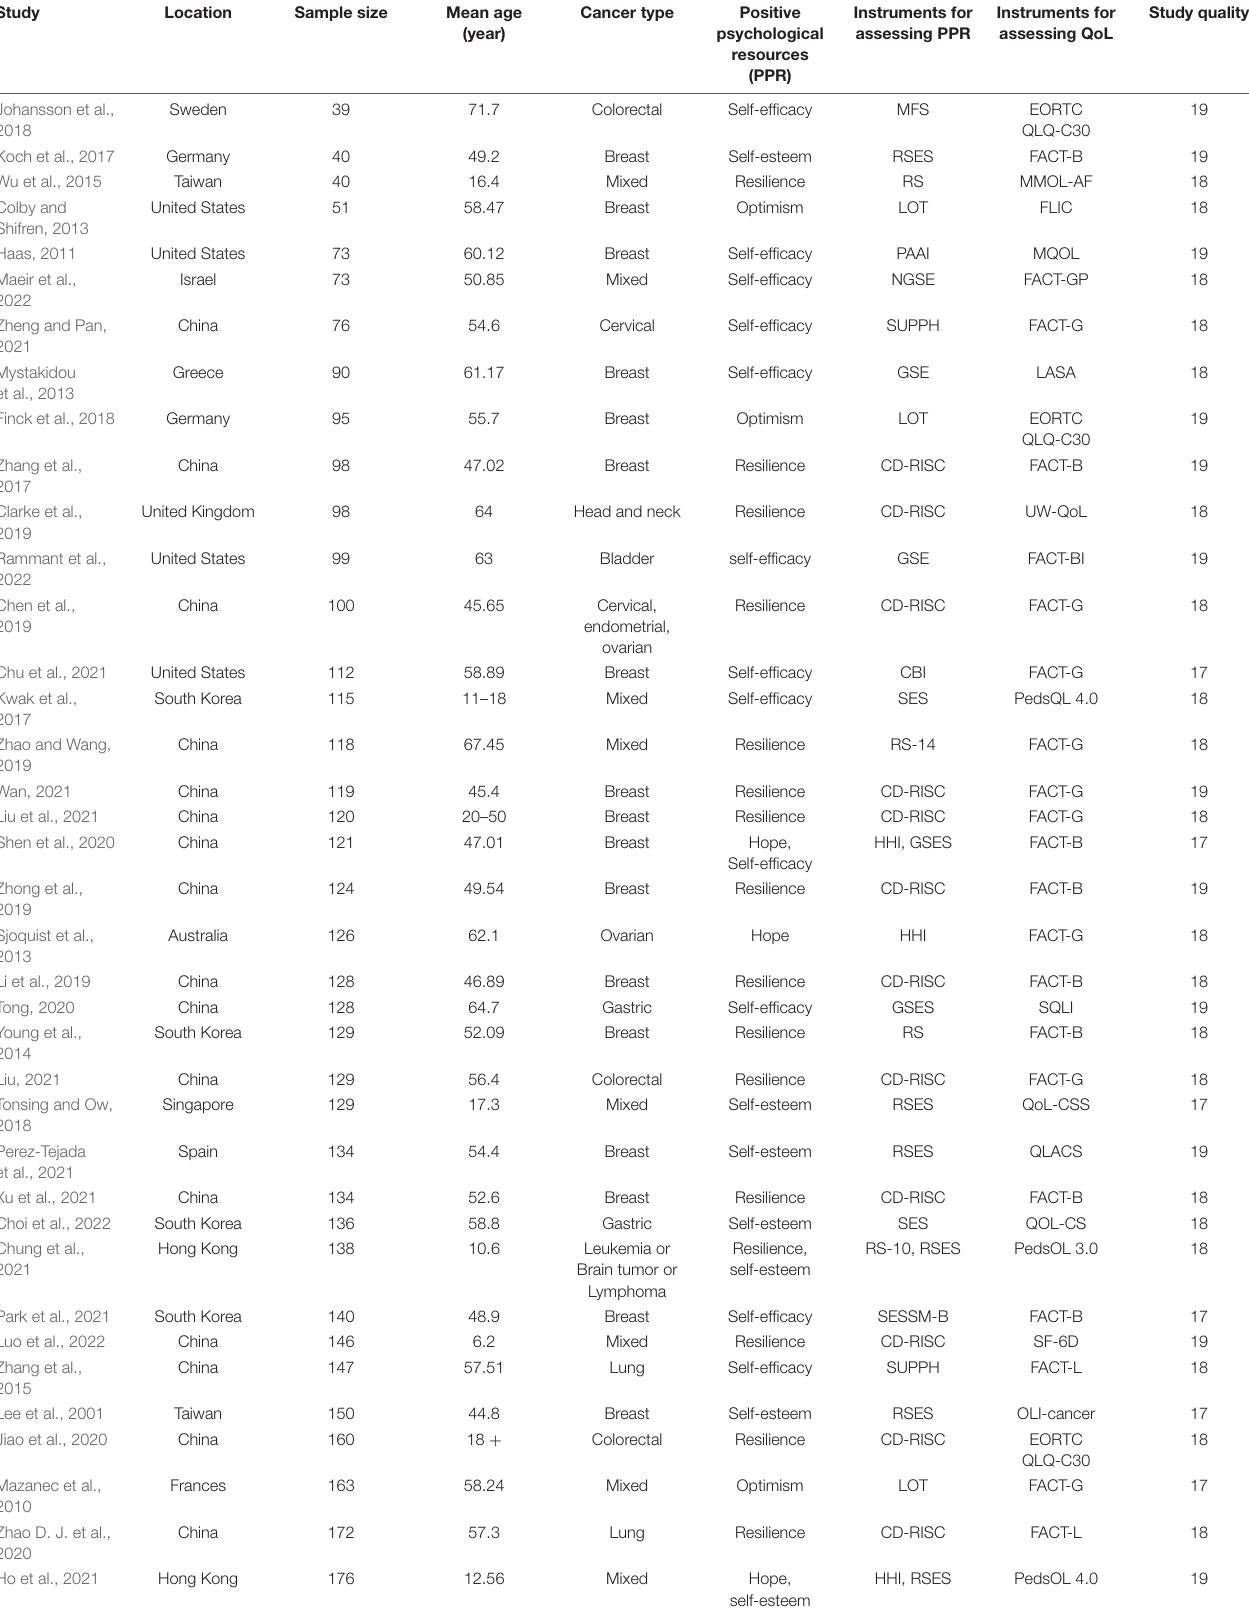
TABLE 1 | Characteristics of included